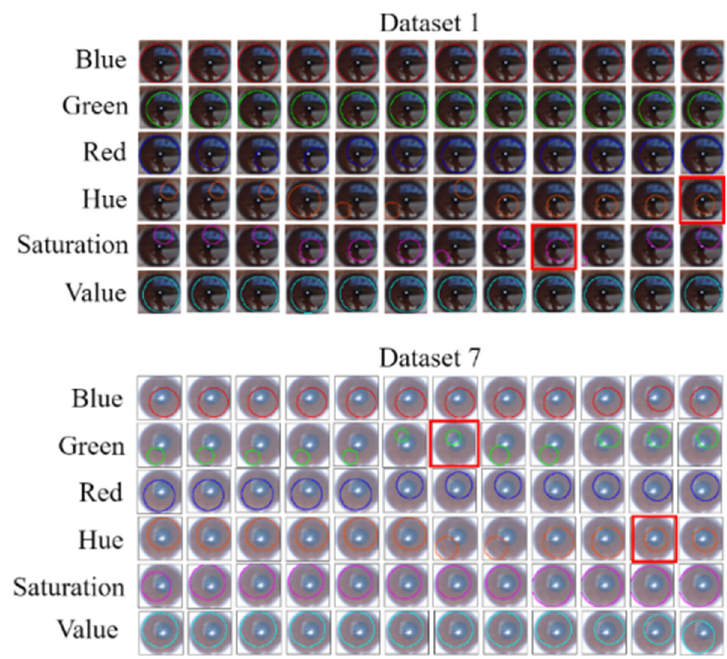
Figure 53. Results of the Hough circle test.